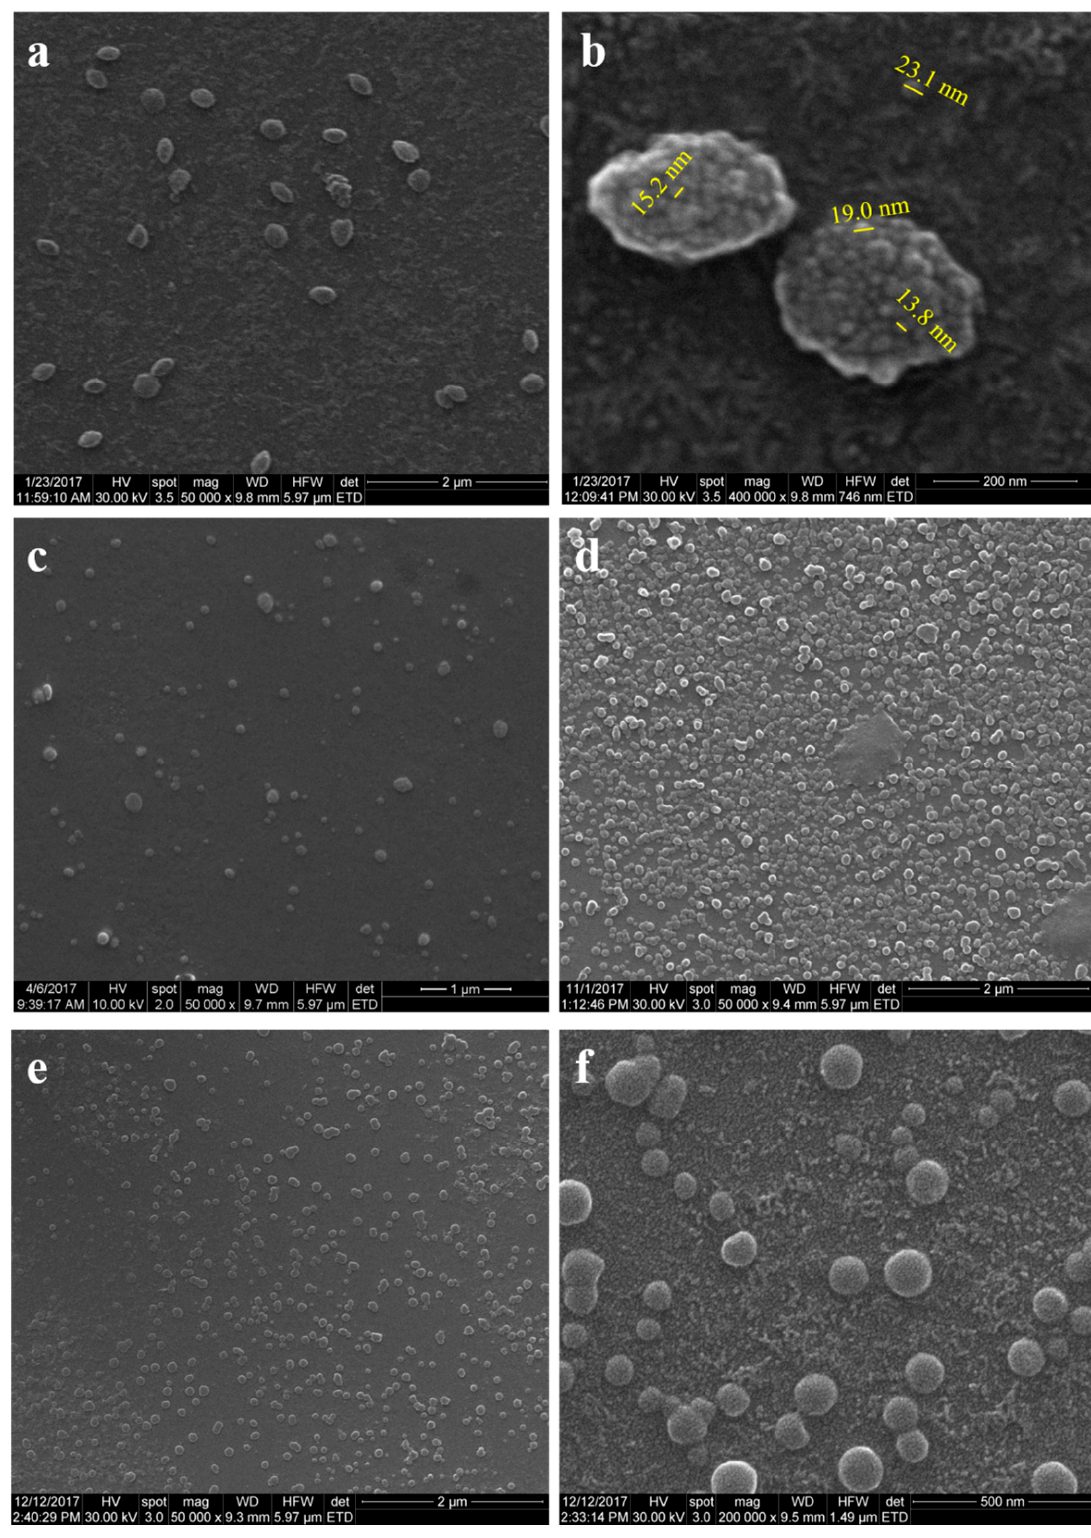
Figure 6. SEM microphotographs for sericin nanoparticles from various sericin concentrations: ( a , b ) SER 1%; ( c , d ) SER 0.5% and SER 0.25%; ( e , f ) SER 0.1%.